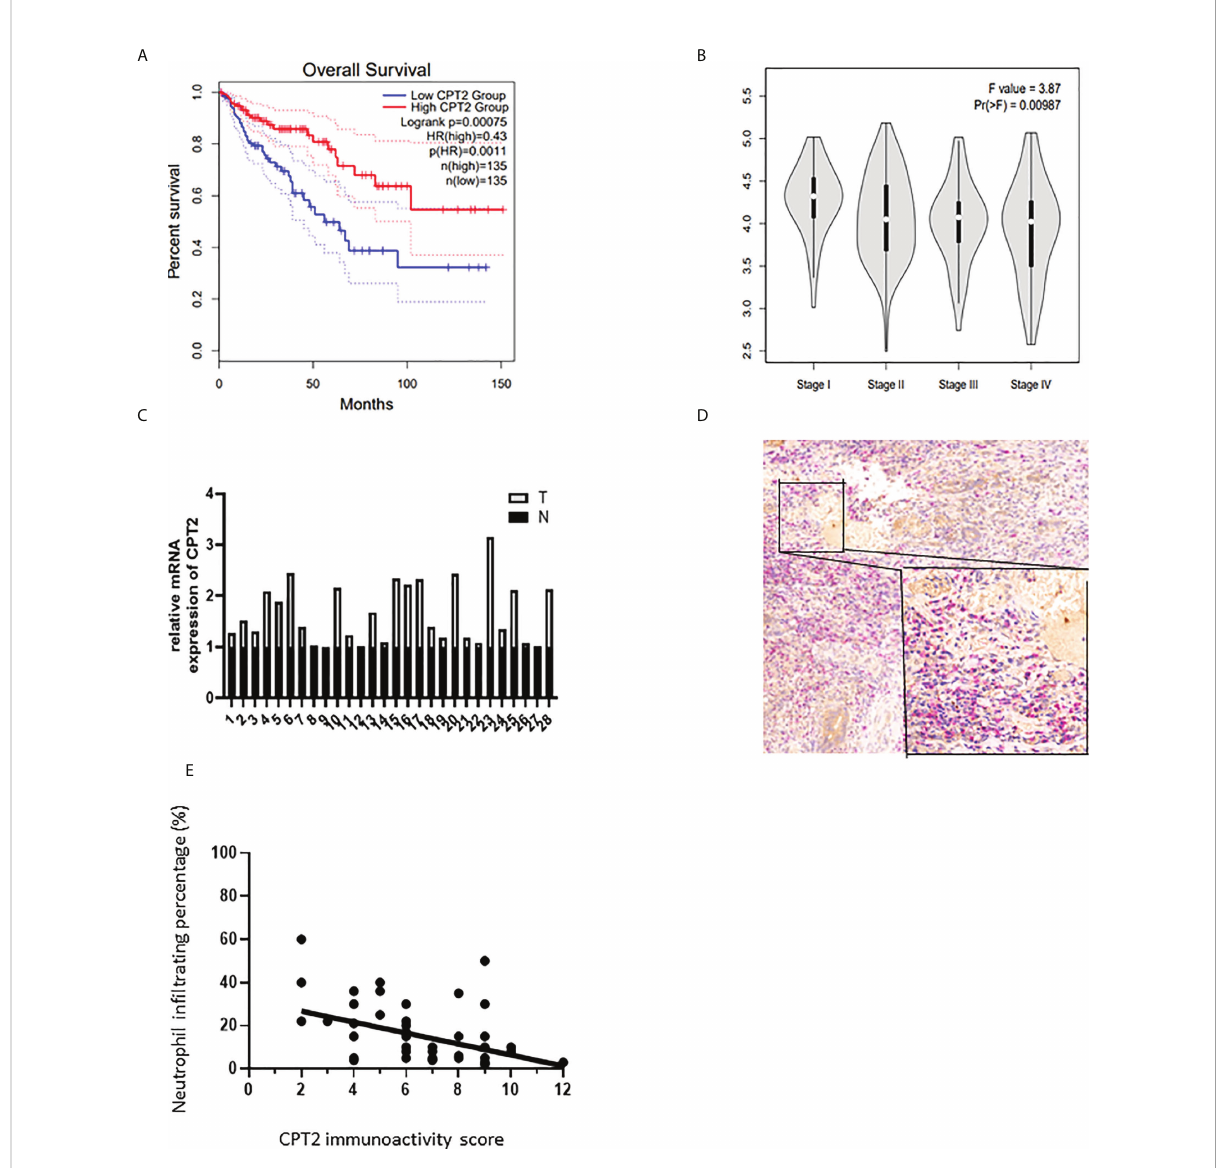
FIGURE 8 Correlation of CPT2 expression and immune in fi ltration in human specimens. (A, B) Correlation of CPT2 expression with Kaplan – Meier curves and clinical stages in COAD patients. (C) Relative mRNA expression of CPT2 in 28 paired human specimens, N normal vs. T tumor. (D) Representative multiplexed IHC image of tissue area (2 mm × 1.5 mm) with an enlarged image for COAD human specimens, showing staining of CPT2 (brown) and MPO (red). (E) Spearman correlation analyses suggested that the expression of CPT2 negatively correlated with that of MPO (Spearman r = − 0.42, p < 0.01). Scale bars are 20 and 200 m m in (D)